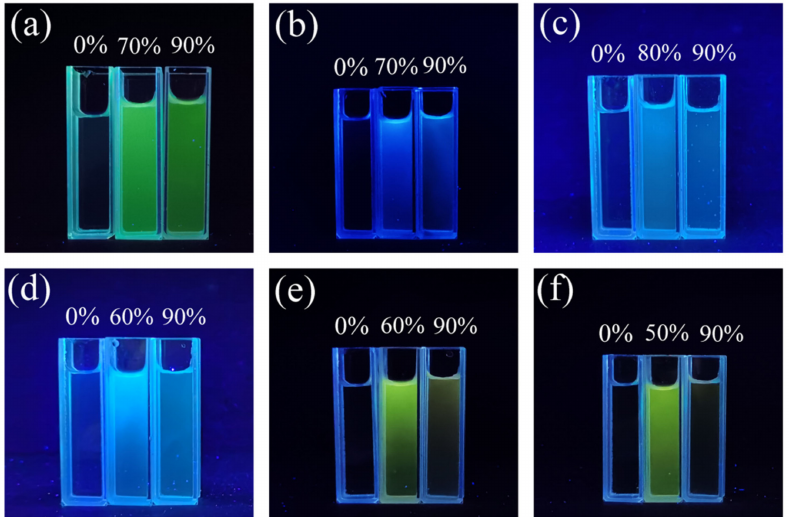
Figure 4. Fluorescence photographs of compounds ( a ) 1 , ( b ) 2 , ( c ) 3 , ( d ) 4 , ( e ) 5 , ( f ) 6 in CH 3 OH/H 2 O mixed solution (with various water fractions) under 365 nm wavelength UV